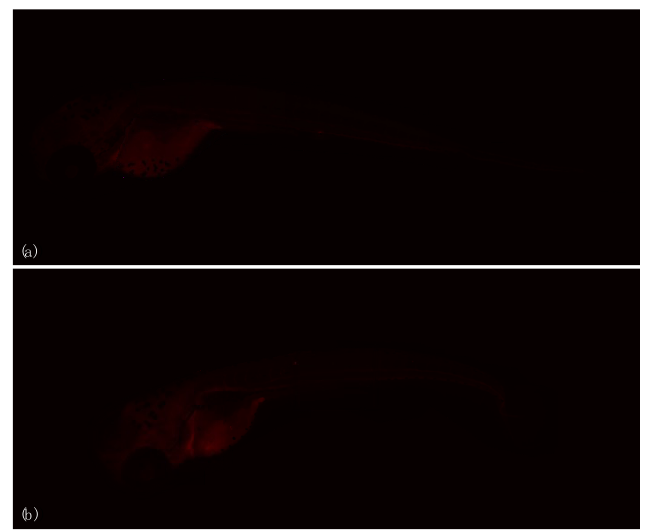
Figure 6. Immunohistochemical investigation of HSP70 biomarker in larvae unexposed ( a ) (CTRL) and exposed ( b ) (EXP) to 27 GHz at the end of exposure.